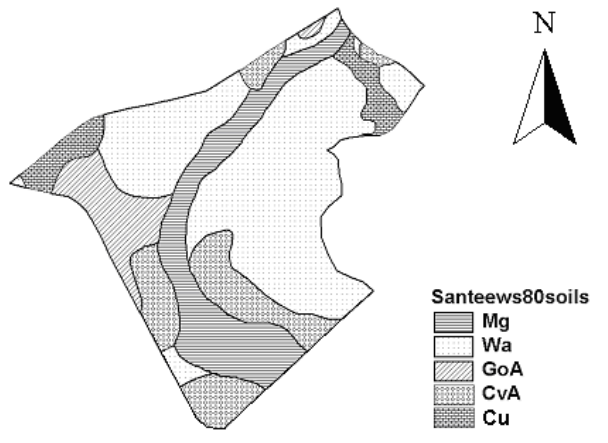
Fig.2b. Vegetation types in WS80 Fig. 2b. Vegetation types in